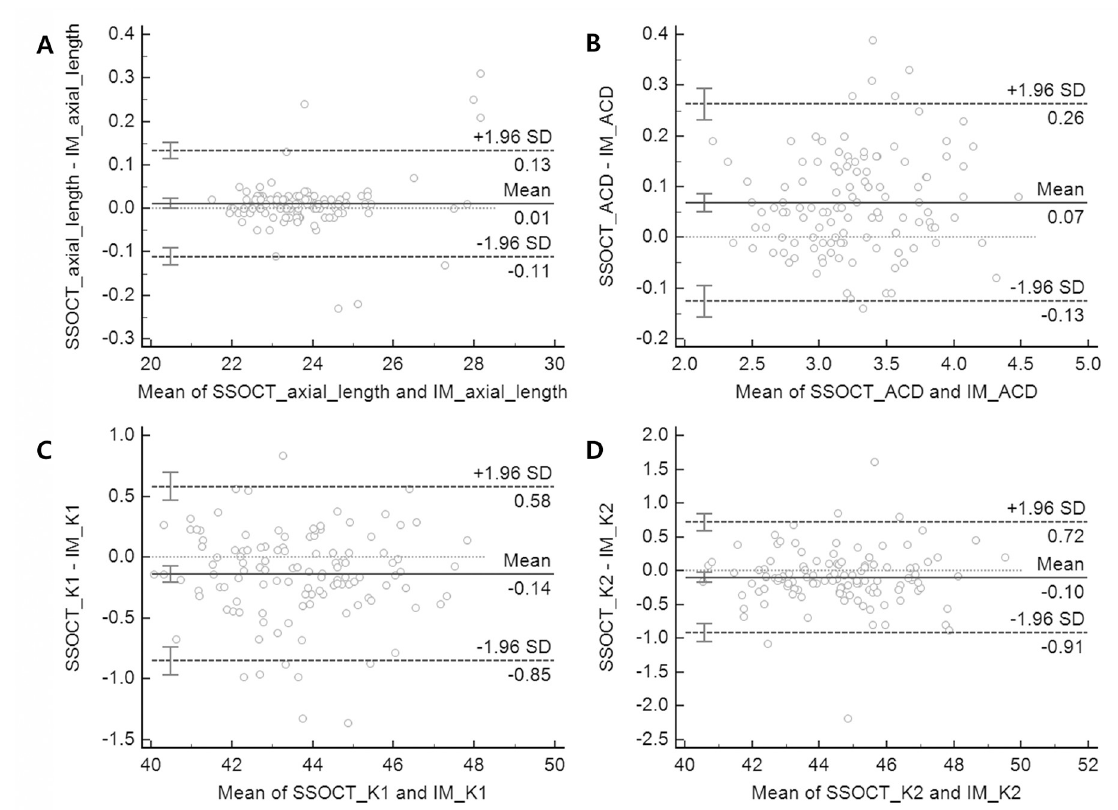
Fig 1. Bland-Altman plot of agreement between swept-source optical coherence tomography and partial coherence interferometry. (A) axial length, (B) ACD, (C) flat K (K1), (D) steep K (K2). The mean difference is indicated by the black dashed lines, and 95% LoA is indicated by the black dashed line. The grey doted line indicate the draw line of